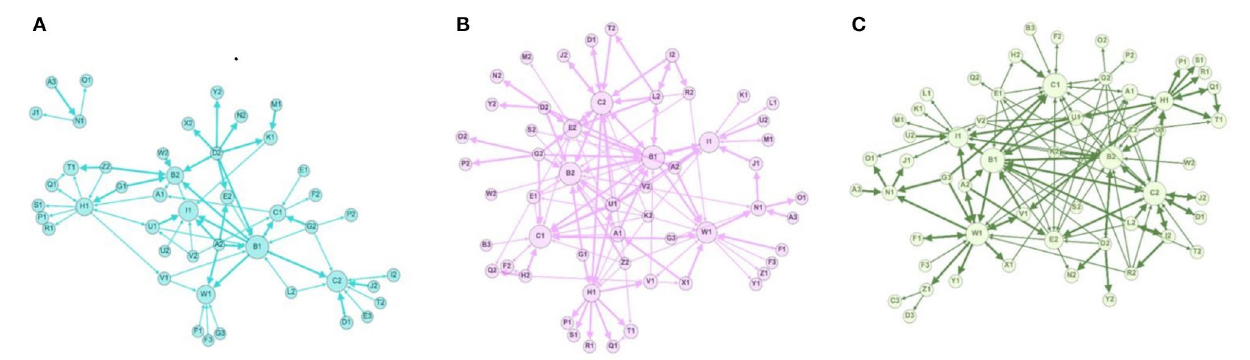
Weighted edges in-degree mean (std)